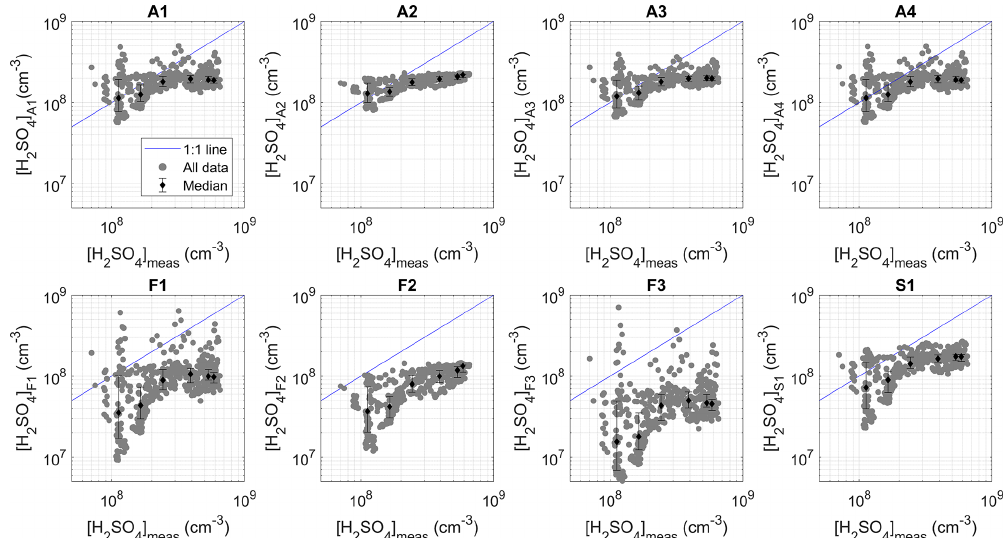
Figure 7. Predictions retrieved by the different proxies as a function of [H 2 SO 4 ] measured during STRAP. The data points were also divided into six bins with an equal number of data points based on measured [H 2 SO 4 ]. The medians (markers) and the 25th and 75th percentiles (error bars) of [H 2 SO 4 ] predicted in each bin are also